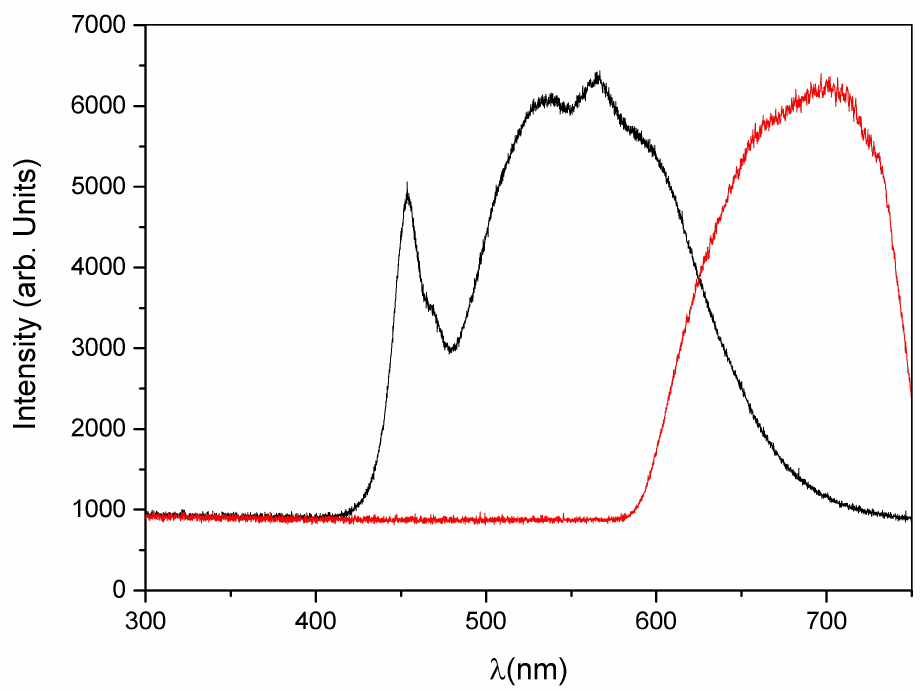
Figure 1. Absorption spectra of the incoherent lamps used in our experiments (black line = white LED lamp; red line = NIR lamp). The intensity impinging on the sample is ≈ 50 mW/cm 2